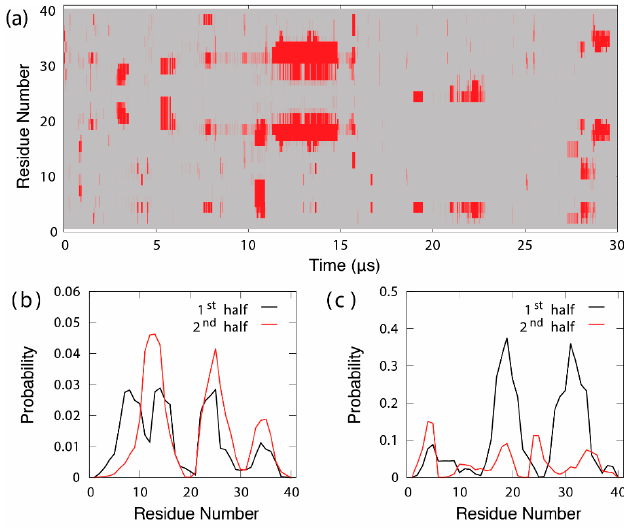
Figure 1. ( a ). Evolution of the per-residue β -sheet structure during a 30- µ s Anton MD simulation of intrinsically disordered A β 40 in explicit solvent at 300 K. Residues assigned to be in the β -sheet conformation are colored in red. ( b ) Average residue helix and ( c ) β -sheet probability profiles derived from the first and second halves of the trajectory. Note that both pairs of profiles differ significantly, reflecting a lack of convergence in the simulated disordered ensemble. The original MD trajectory was generously provided by D. E. Shaw Research [92].